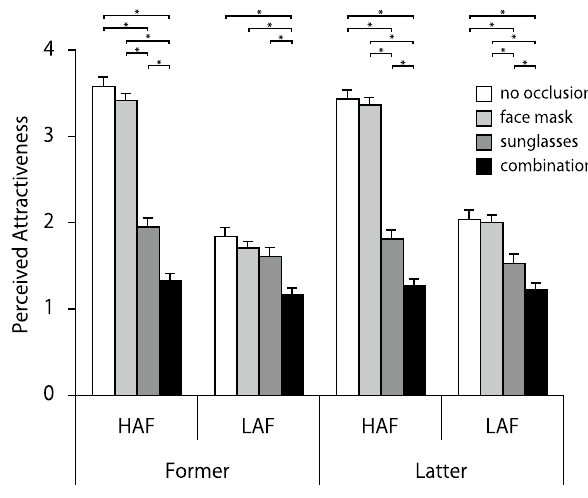
Fig. 3 Mean attractiveness ratings for each condition. Error bars represent standard errors. Lines with * indicate that Bonferroni-corrected pairwise comparisons between conditions were significant, p < .05